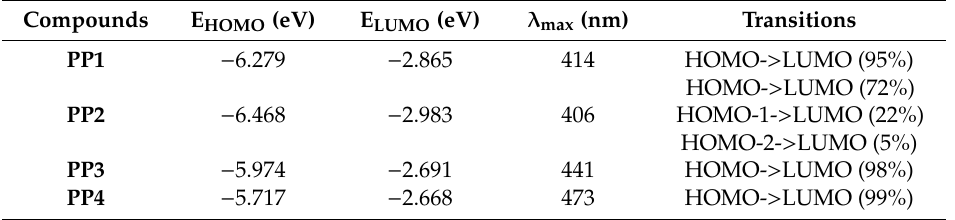
Figure 6. Simulated absorption spectra in dilute dichloromethane (5 × 10 − 3 M) of synthetized compounds PP1 – PP10 ( a ) and PP11 – PP20 ( b ). Table 2. Summary of simulated absorption characteristics in dilute dichloromethane of synthetized compounds. Data were obtained in dichloromethane solution.